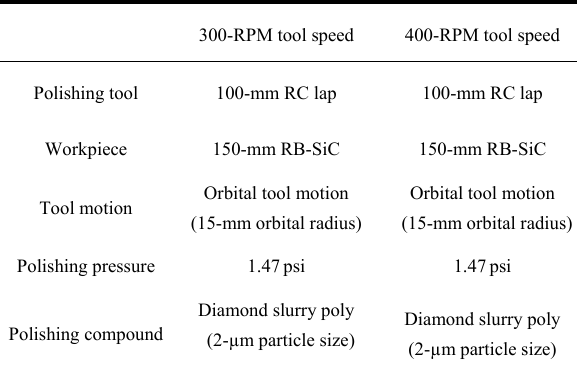
Table 3 Experimental conditions for